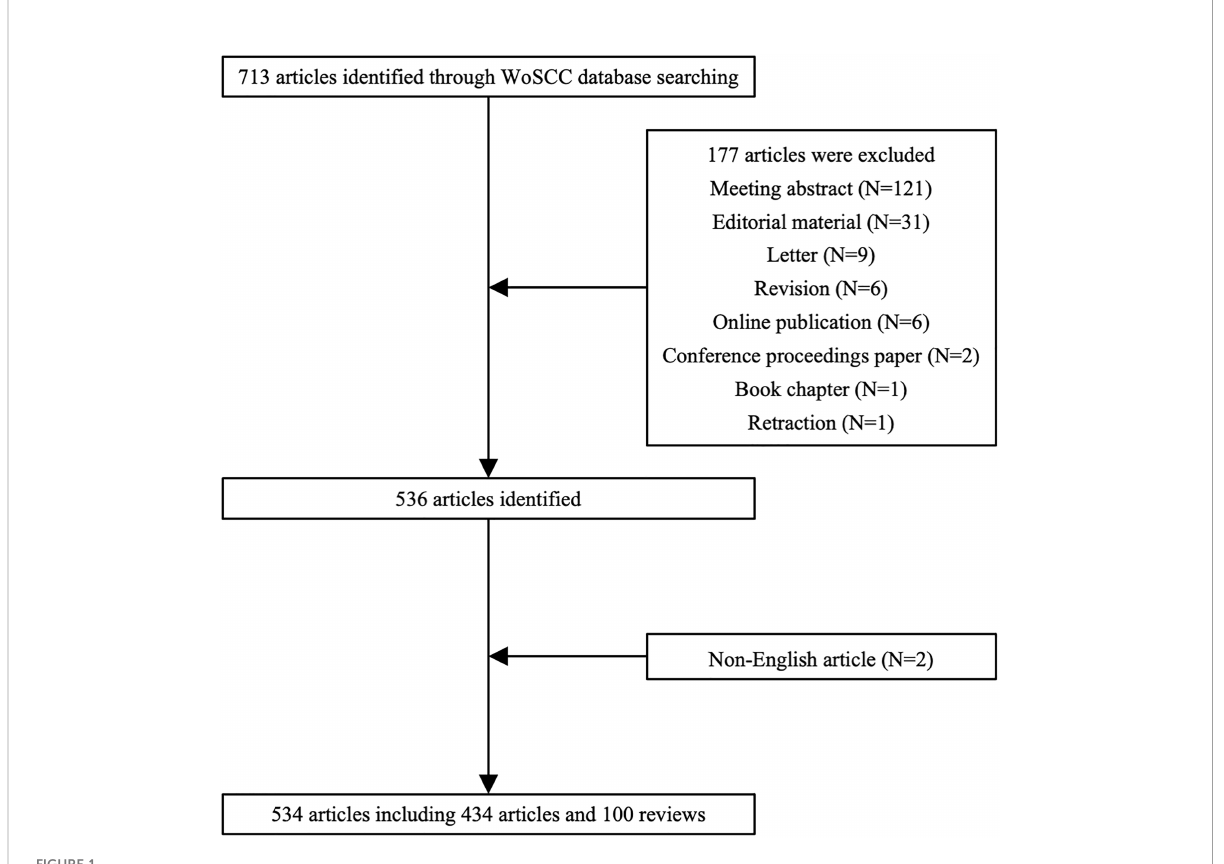
FIGURE 1 Flowchart of the screening